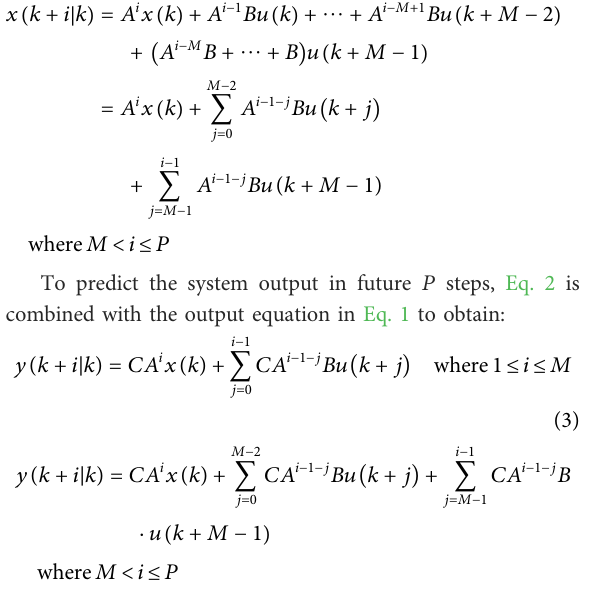
FIGURE 2 Schematic diagram of receding horizon